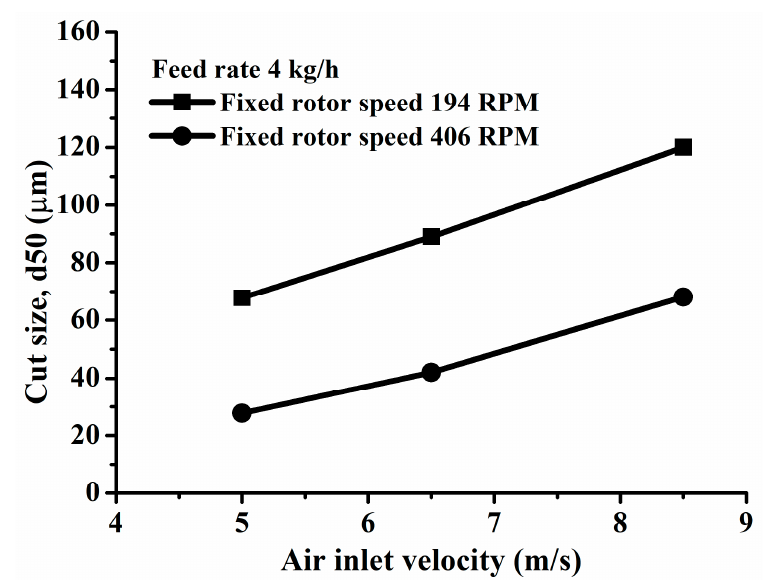
Figure 9. Plot cut size against air inlet velocity from the experiments performed at constant rotor speeds of 194 and 406 RPM and feed rate 4 kg/h.